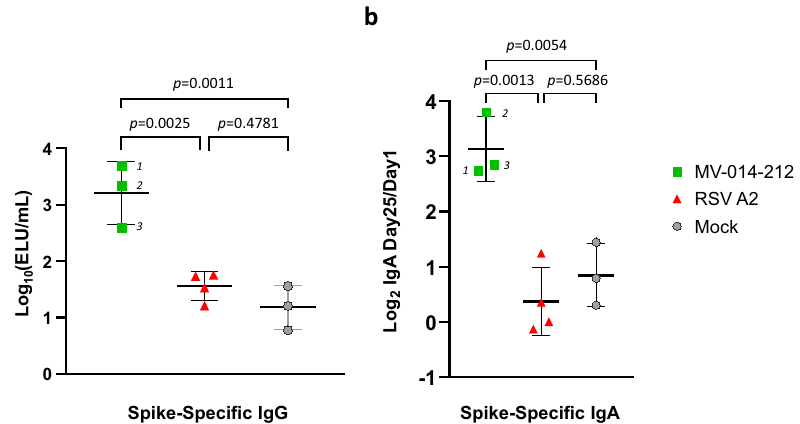
Fig. 4 Spike-speci fi c antibody responses in MV-014-212-inoculated African green monkeys (AGMs). a Spike-speci fi c serum immunoglobulin (Ig) G antibodies were measured by ELISA using serum collected on day 25 from AGMs inoculated with MV-014-212, wild-type respiratory syncytial virus (RSV) A2, or phosphate-buffered saline (mock). The titer was expressed as ELISA units (ELU/mL) calculated by comparison against a standard curve generated with a pool of human COVID-19 convalescent serum (Std/012020, Nexelis). b IgA antibodies speci fi c to SARS-CoV-2 spike protein were measured by ELISA using nasal swabs collected on day 25 post-inoculation. The Log 2 of the ratio of the values obtained at day 25 over day 1 are shown. The calculated ELU/mL concentration was obtained from a standard curve generated using total puri fi ed human IgA by a capture ELISA. For ( a ) and ( b ), N = 3 AGMs for the MV-014-212 and mock groups and N = 4 AGMs for the RSV A2 group. Statistical analysis was one-way ANOVA using Tukey ’ s multiple comparisons test. p- values are shown. Vaccine responses for individual AGMs are indicated as (1) O9720, (2) C8959, and (3) C6672 in panel ( a ) and ( b ). Bars are mean and error bars denote